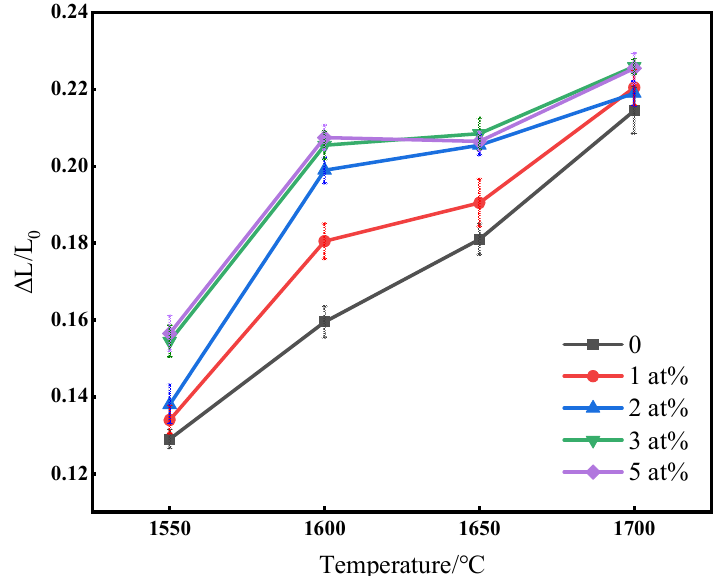
Figure 3. Linear shrinkage rate with varying ZrO 2 contents after hydrogen sintering from 1550 °C to 1700 °C.